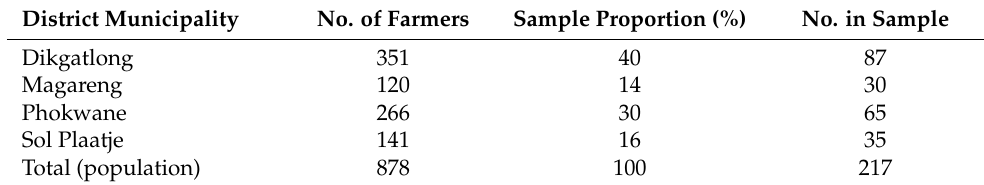
Table 1. Farmer composition by location.